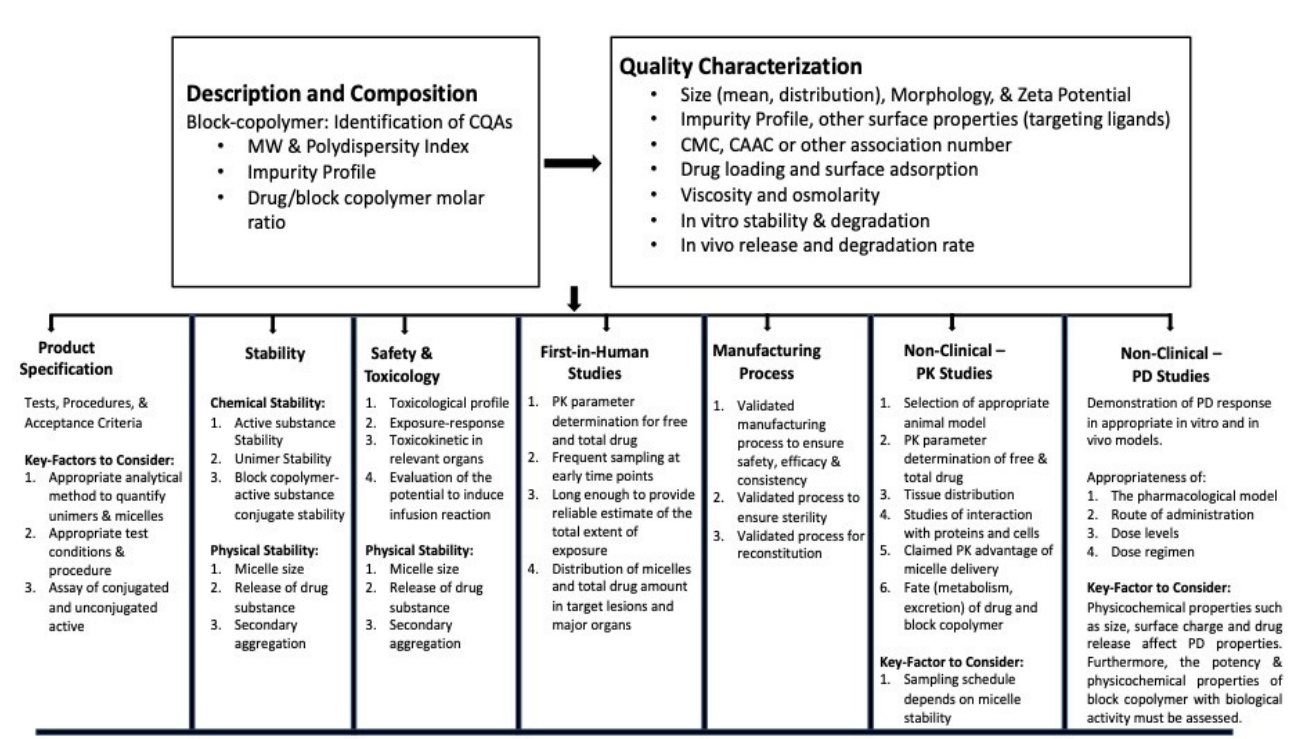
Figure 8. Schematic of regulatory process of a nanoparticle (including micellar nanoparticles) based drug delivery system. Abbreviations: CQA: critical quality arrtribute; MW: molecular weight; CMC: Critical Micelle Concentration; CAAC: Critical Assembly/Aggregate Concentration; PK: pharmacokinetics; PD: pharmacodynamics.